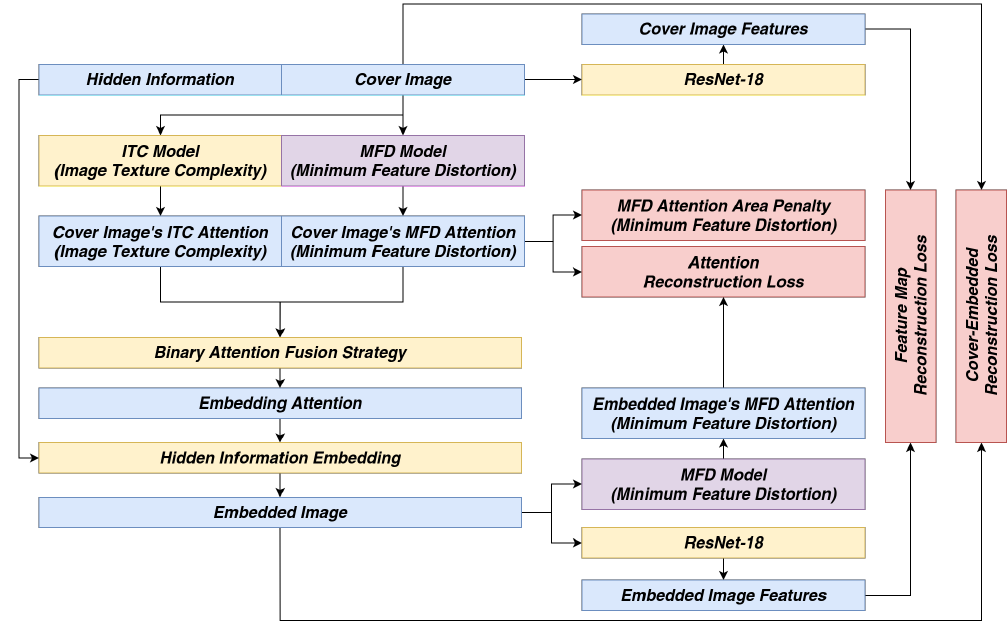
Figure 14. The 2nd phase fine-tune